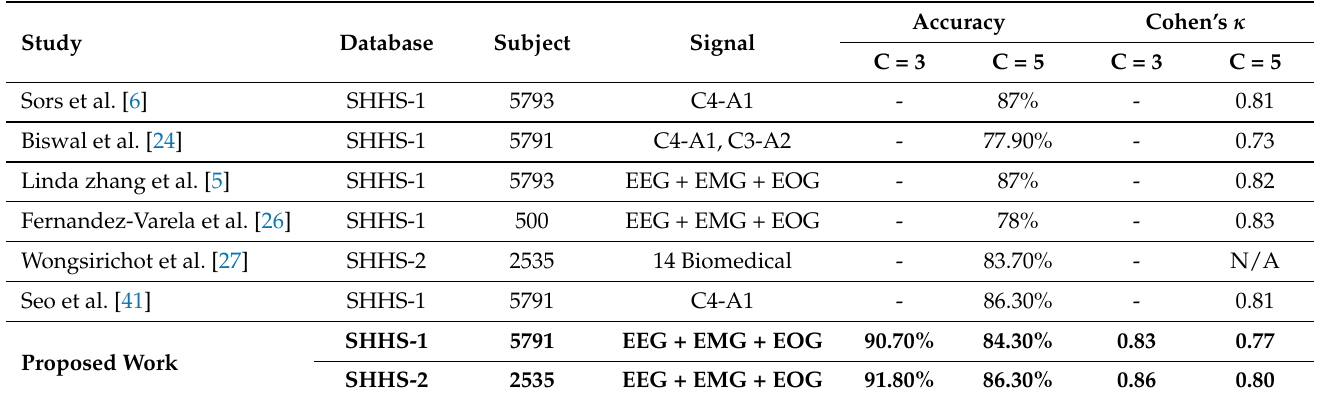
Table 8. Comparison with existing state-of-the-art approaches in terms of accuracy and Cohen’s κ